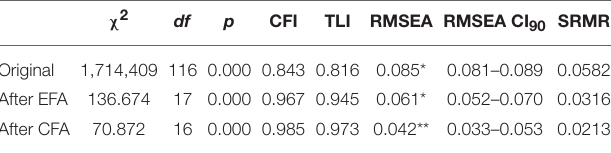
TABLE 1 | Comparison of model fit values between original and respecified measurement models.